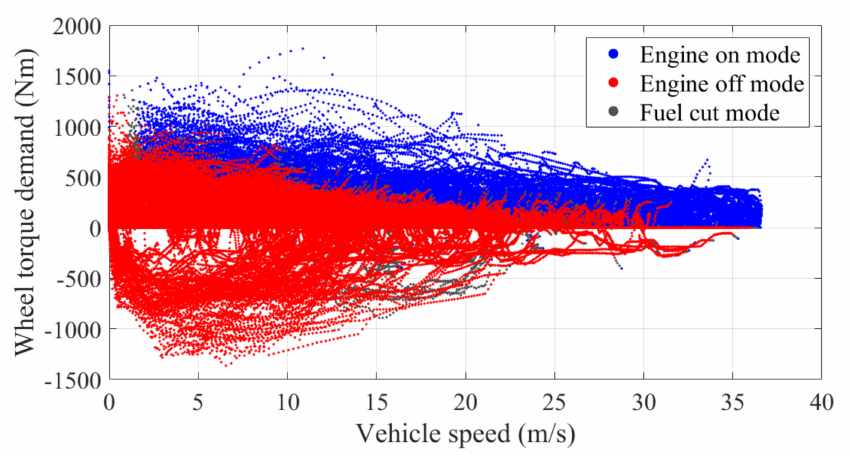
Figure 8. All Operating Points According to the Engine Status.